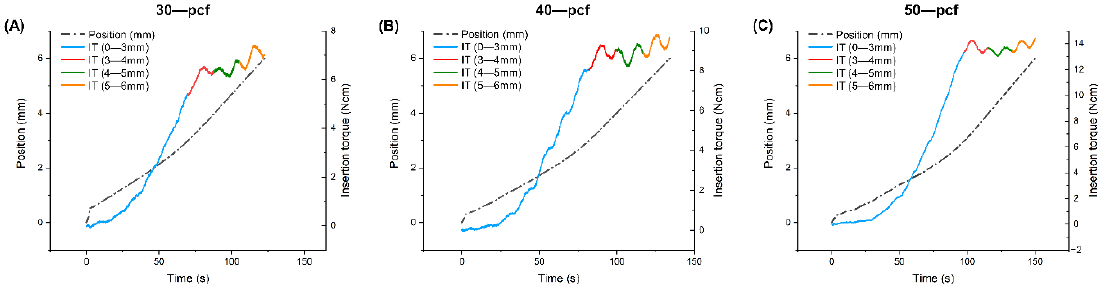
Figure 4. Position and insertion torque (IT) during insertion of the miniscrews into ( A ) 30, ( B ) 40, and ( C ) 50 pcf artificial cortical bone.